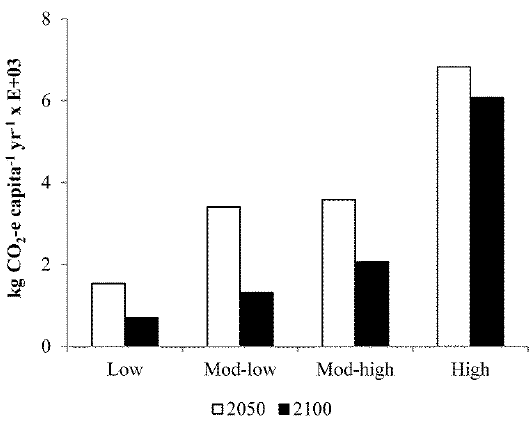
Figure 3. GHG emissions impact (kg CO 2 -e) per area of peri-urban (PU) land transformed for housing under the four future scenarios at time horizons 2050 and 2100. Contributions are displayed from the components: new housing in existing urban location; new housing in greenfield location; replacement lettuce; and iLUC.